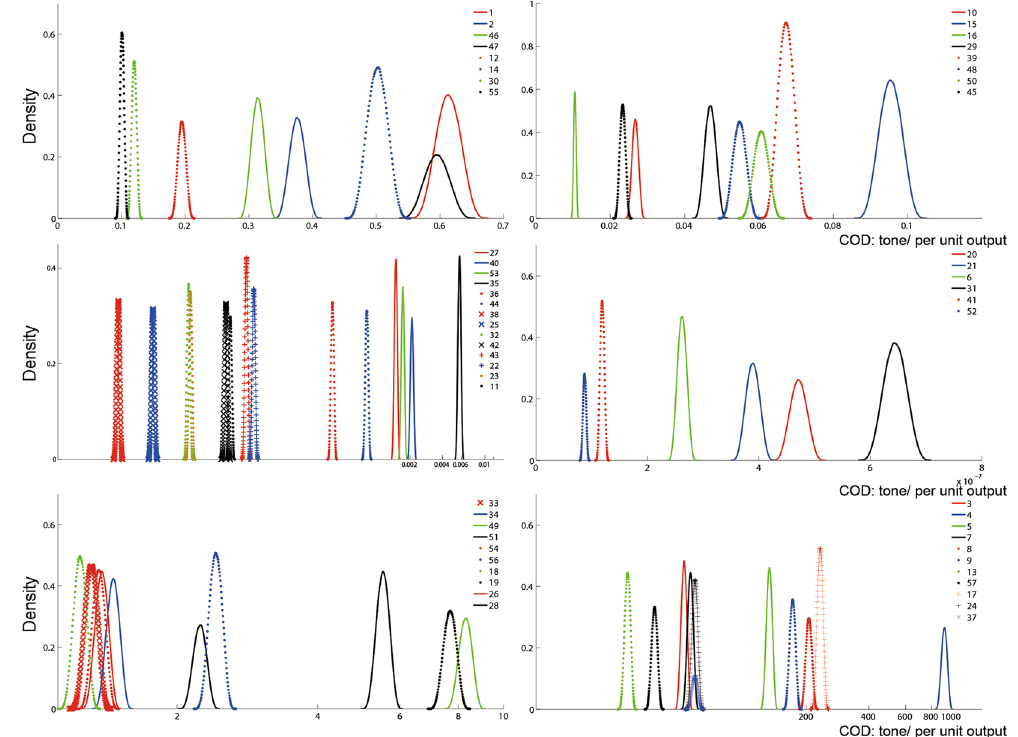
Figure 1. Uncertain feature of COD discharge in 57 industrial products of Dalian City. Based on the hybrid approach for data analysis, uncertain features of COD discharges in 57 industrial products of Dalian City can be described as probability density functions. Code numbers of products in the figure are listed in Table S3 of Supplementary